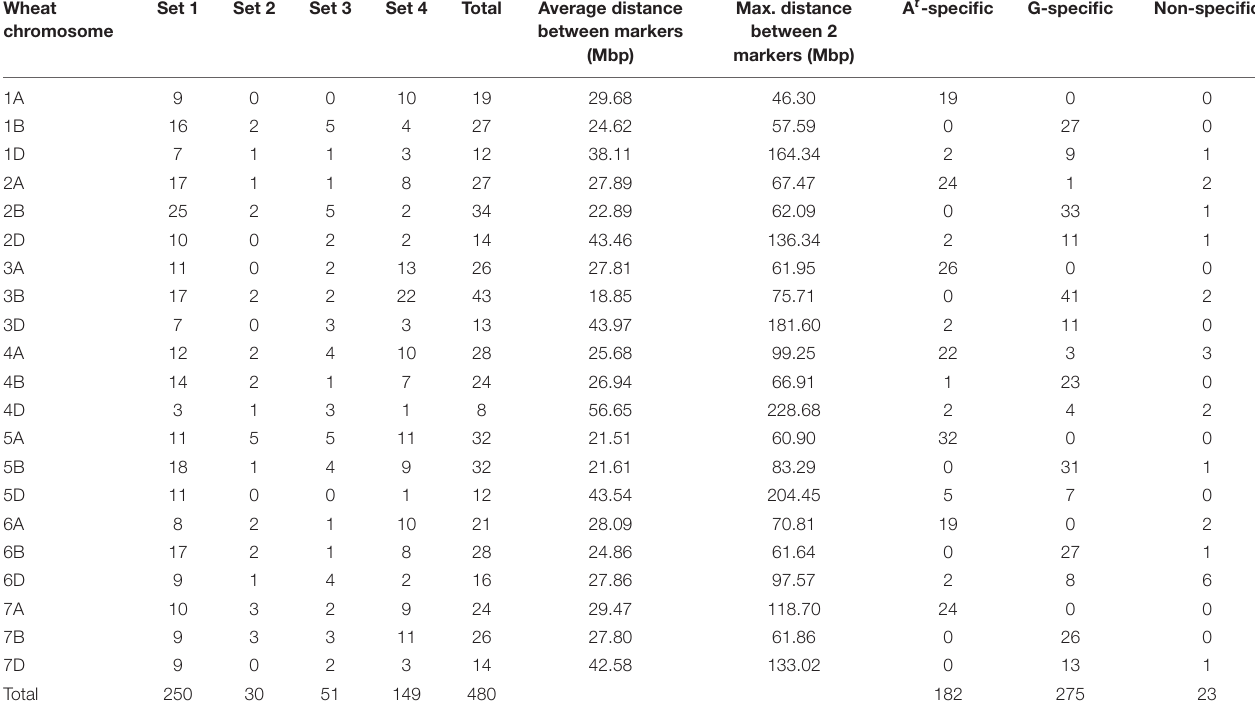
TABLE 1 | Number of chromosome-specific markers across the different sets of markers tested, average and maximum distance between markers and Triticum timopheevii subgenome-specific markers per wheat chromosome. Wheat Set chromosome